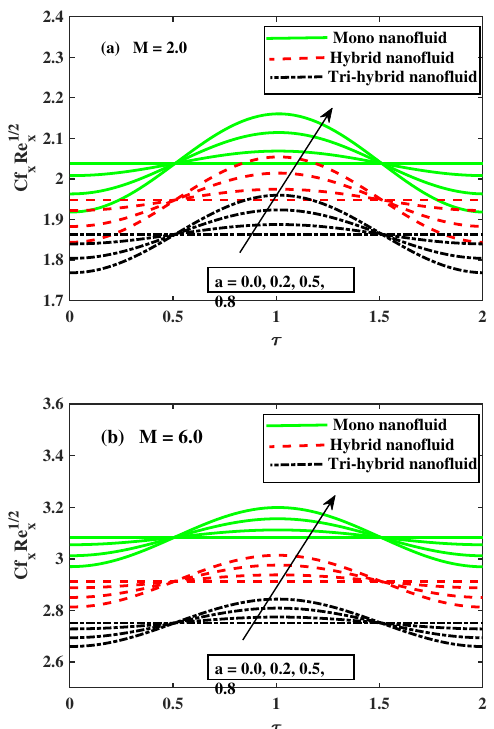
Figure 5. ( a ) Fluctuation of M on Cf x Re 1/2 x ; ( b ) Fluctuation of M on Cf x Re 1/2 x .